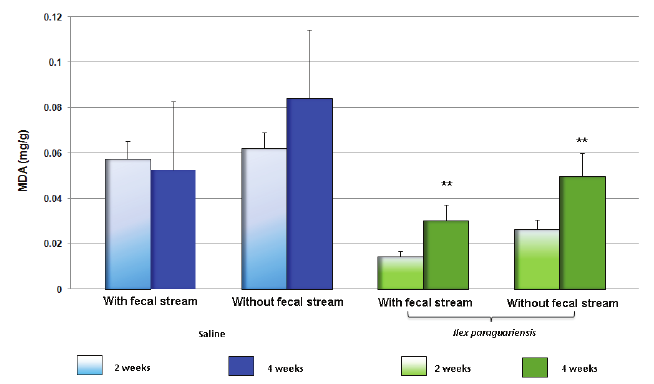
FIGURE 5 – Tissue levels of MDA comparing colon segments with and without fecal stream irrigated for two or four weeks with saline or aqueous extract of Ilex paraguariensis . **significant; p<0.05. Kruskal-Wallis